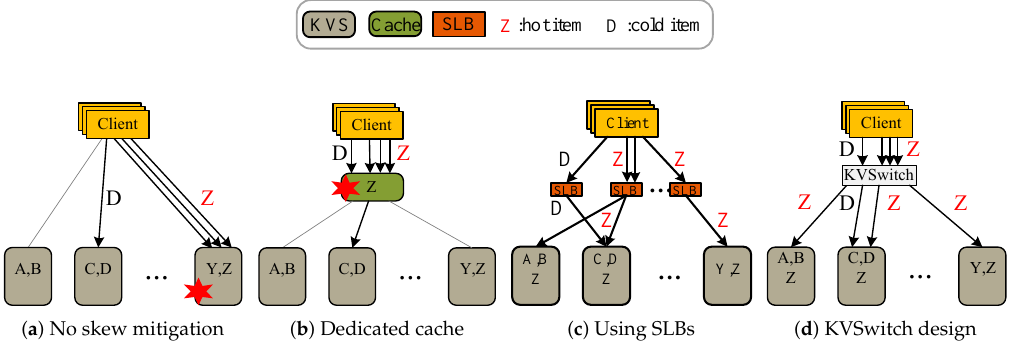
Figure 1. Design of different skew mitigation